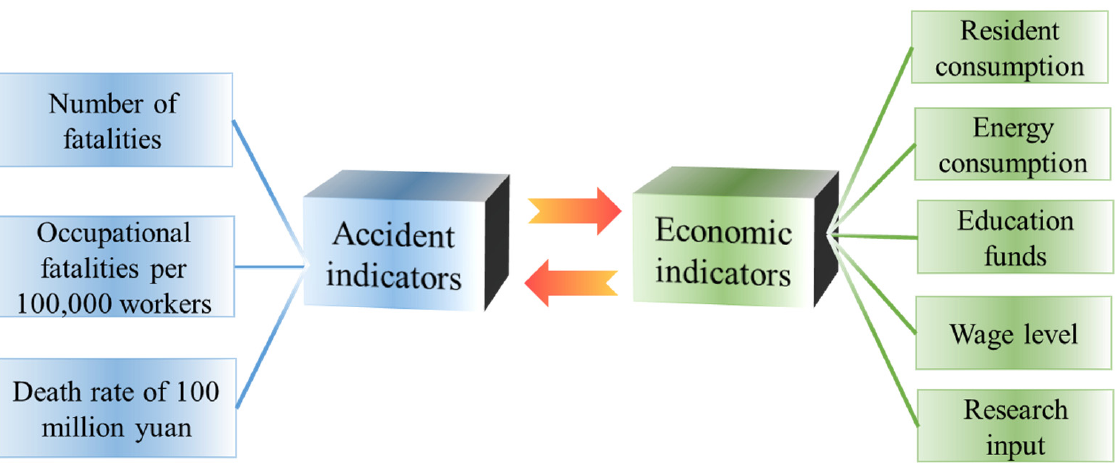
Figure 4. Characteristic system of correlation between accidents and economic indicators.